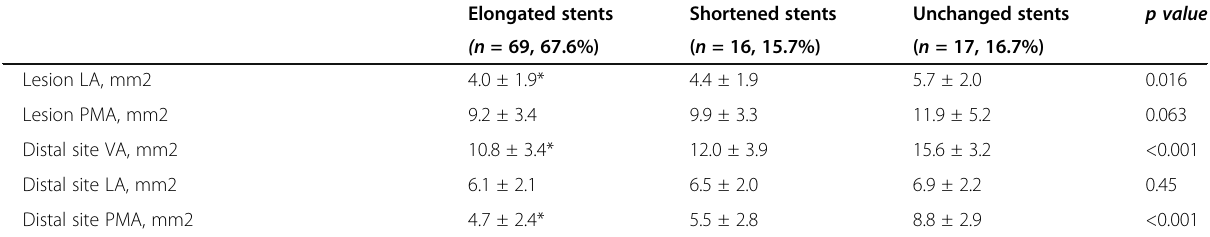
Table 1 Baseline characteristics by groups (Continued) Elongated stents Shortened stents Unchanged stents